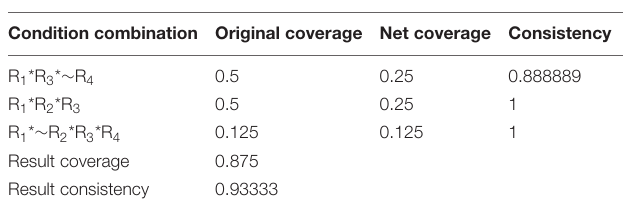
TABLE 6 | fsQCA output: intermediate solution result.